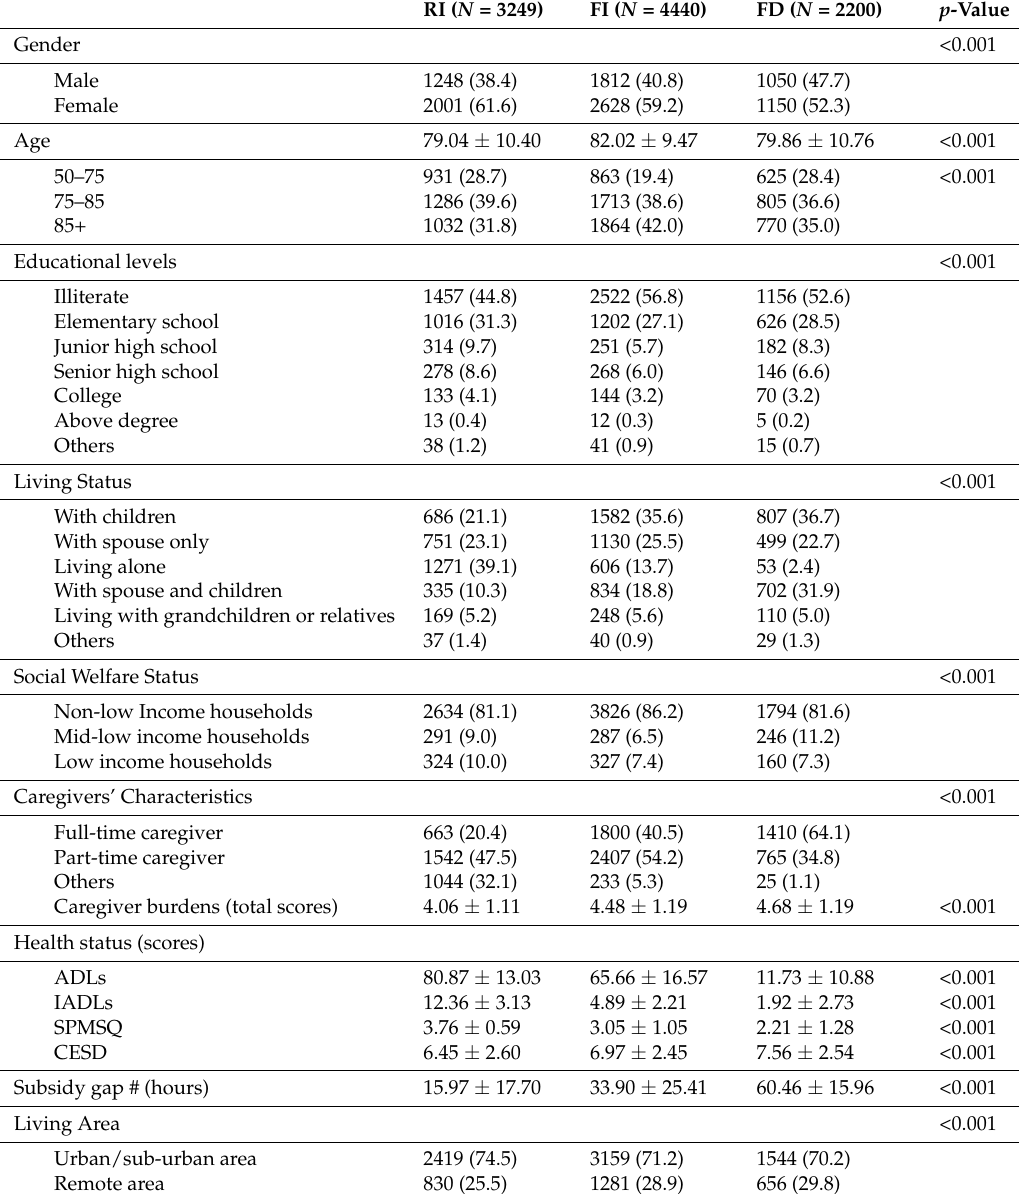
Table 2. Socio-demographic characteristics and health status of the three profiles of care recipients in the Long-Term Care Dataset at